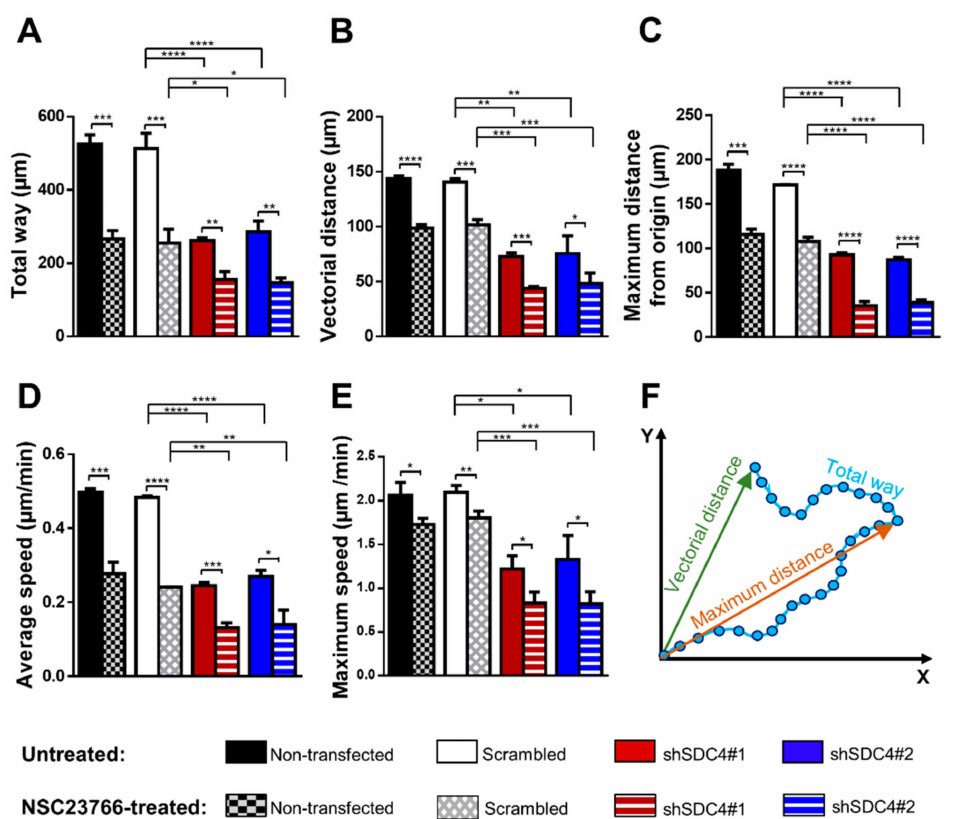
Figure 1. The role of syndecan-4 and Rac1 (Ras-related C3 botulinum toxin substrate 1) in random, two-dimensional migration of myoblasts. The total length of movement ( A ), the vectorial distance (real displacement of the cells) ( B ), the maximum distance from the starting point ( C ), the average cell speed ( D ), and the maximum speed ( E ) of the cells are depicted in non-transfected, scrambled, and syndecan-4 silenced (shSDC4#1, shSDC4#2) C2C12 myoblast cells either without or with NSC23766 (Rac1 inhibitor) treatment. Schematic representation of the total path, vectorial distance, and maximum distance of the movement ( F ). The total duration of live cell microscopy: 18 h, frame rate: 3 / 1 h; n = 4 independent experiments; 62–114 cells / cell line; and 6–8 fields of view / experiment. Data are reported means of the independent experiments + SEM; **** p < 0.0001; *** p < 0.001; ** p < 0.01; * p <